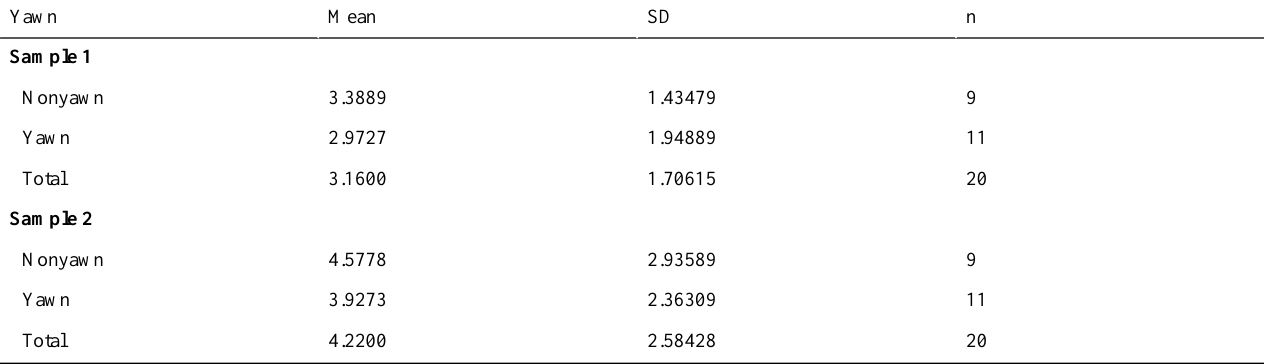
Table 1. Descriptive statistics of